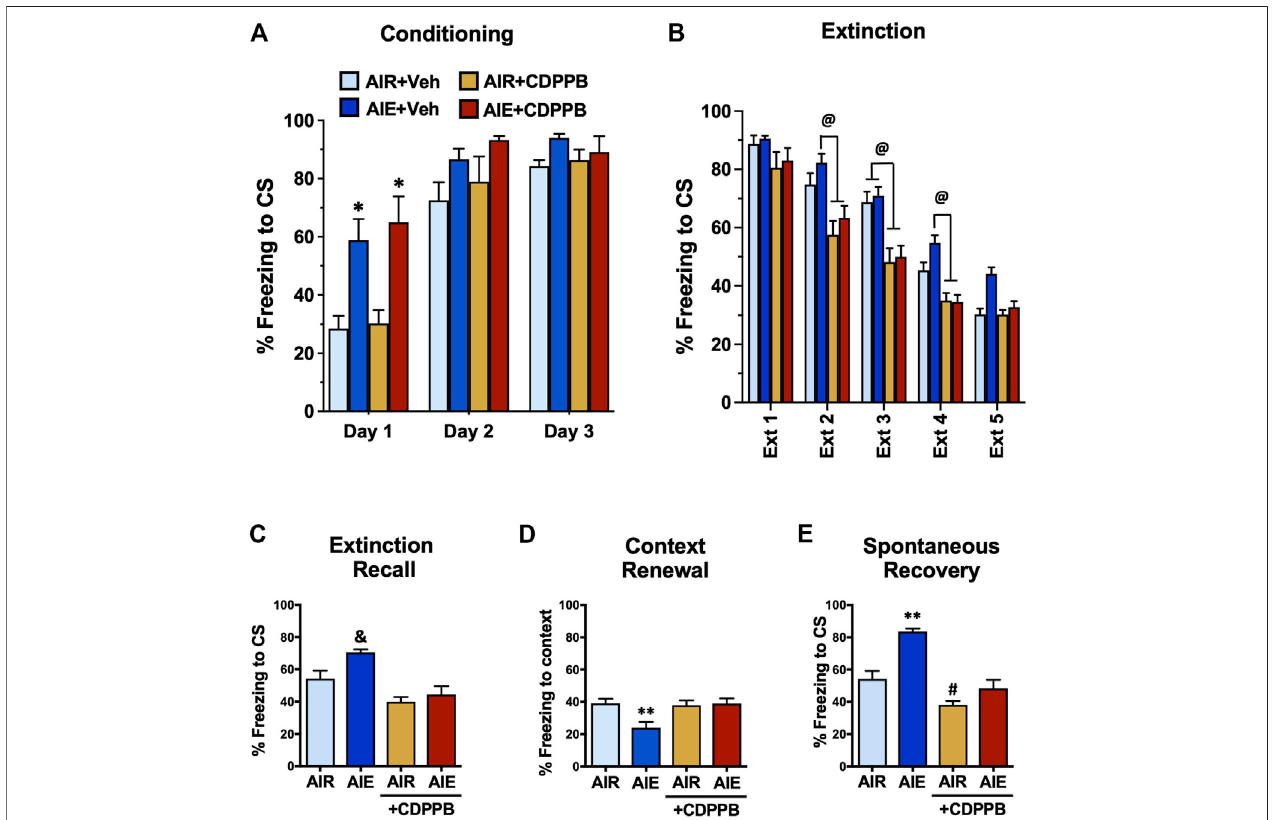
FIGURE 10 | Positive allosteric modulation of mGlu5 receptors reversed AIE-induced alterations of conditioned fear behaviors in adult male rats. (A) Prior to administration of the mGluR5 positive allosteric modulator CDPPB during extinction training, all rats underwent 3 days of conditioning. Only rats that had been exposed toAIEexhibitedsigni fi cantlygreaterfreezingduringconditioning. (B) AdministrationofCDPPB20 minpriortoeachextinctionsessionresultedinsigni fi cantreductionsin freezing on Extinction Day 2 – 4. Subsequent assessment of recall (C) , renewal (D) , and spontaneous recovery (E) revealed that CDPPB administration during extinction training prevented AIE-induced alterations freezing in all three tests of fear responding. *, signi fi cantly different from Day 1 Air + vehicle and Air + CDPPB groups,all p values < 0.05;@,signi fi cantlydifferentfromAir+CDPPBandAIR+CDPPBgroups, p < 0.05;&,signi fi cantlydifferentfrombothCDPPBgroups,all p values < 0.001; **, signi fi cantly different from all other groups, all p values < 0.05; #, signi fi cantly different from AIE group, p =